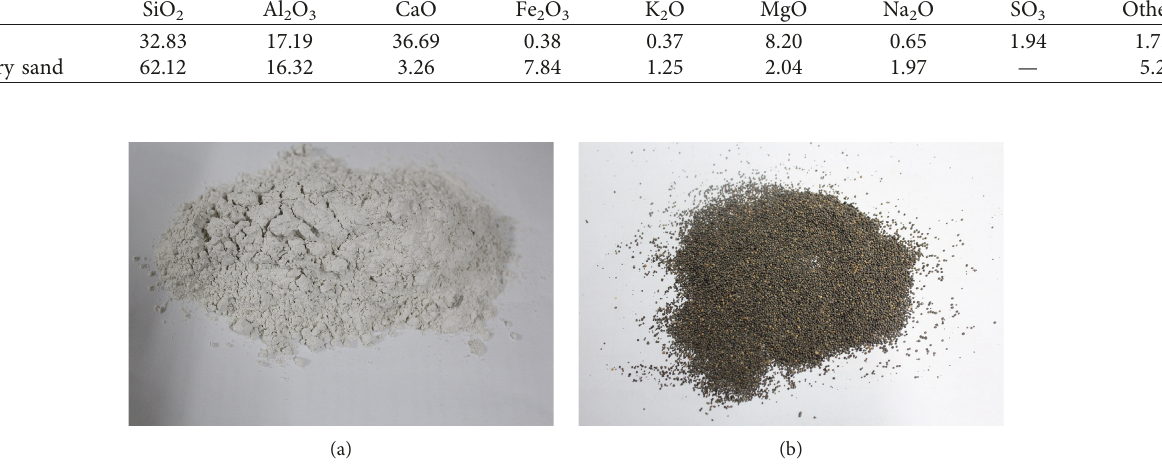
Figure 1: The cementitious material and fine aggregate. (a) Blast furnace slag. (b) Pottery